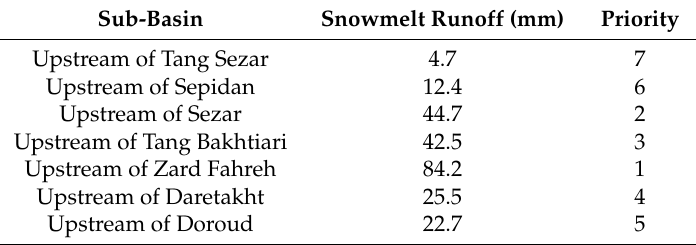
Table 1. Snowmelt runoff volume and the corresponding priority in Dez Basin.